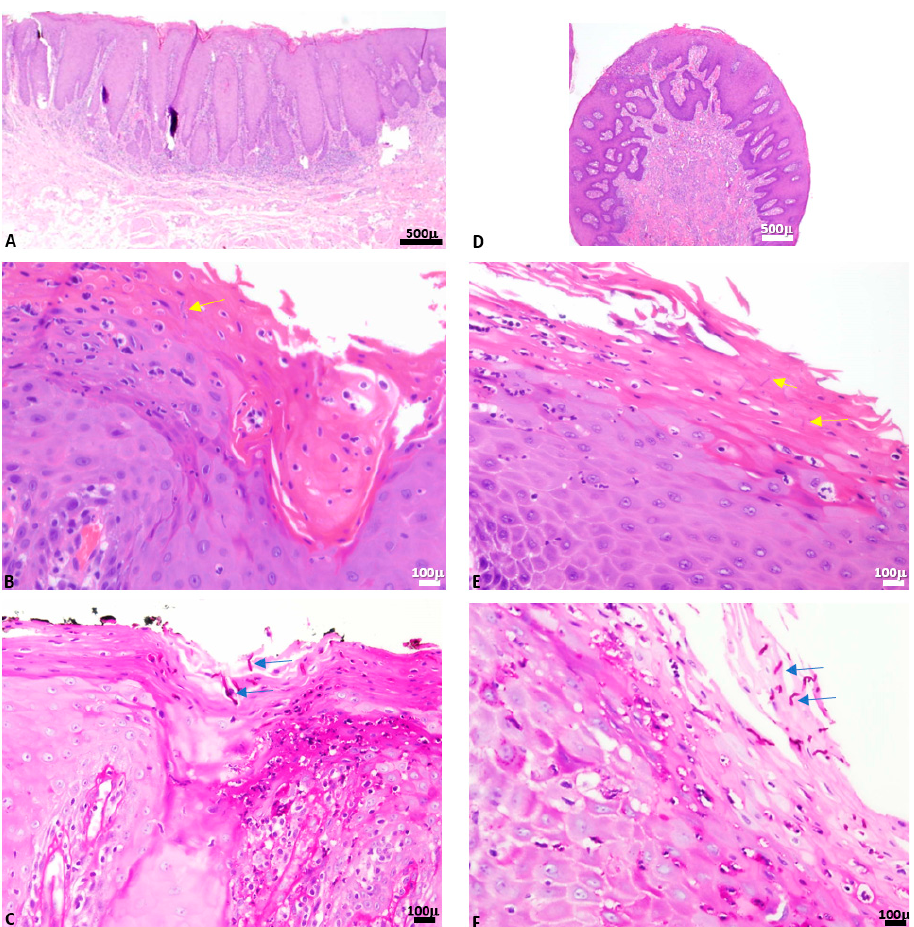
Figure 2. A case of clinically suspected leukoplakia of the buccal mucosa, which microscopically showed epithelial hyperplasia with hyperkeratosis and superimposed candidiasis ( A – C ), and a lesion that had a clinical diagnosis of an exophytic reactive lesion, consistent with irritation fibroma of the buccal mucosa with CH ( D – F ).